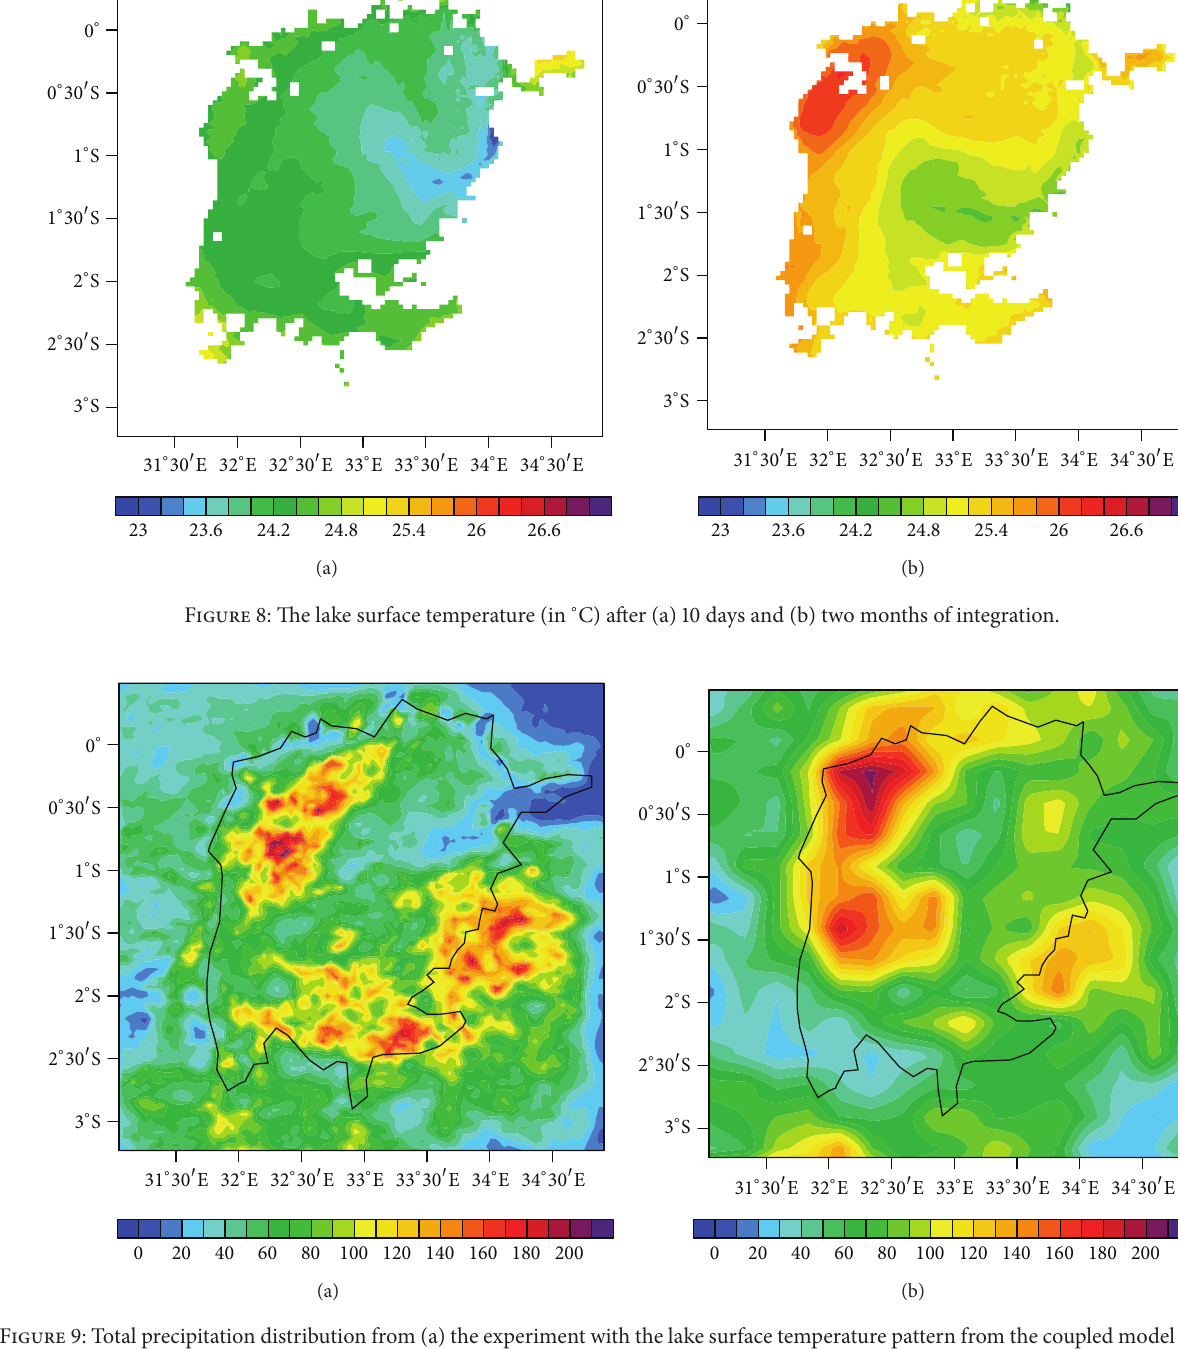
Figure 9: Total precipitation distribution from (a) the experiment with the lake surface temperature pattern from the coupled model and (b) the TRMM